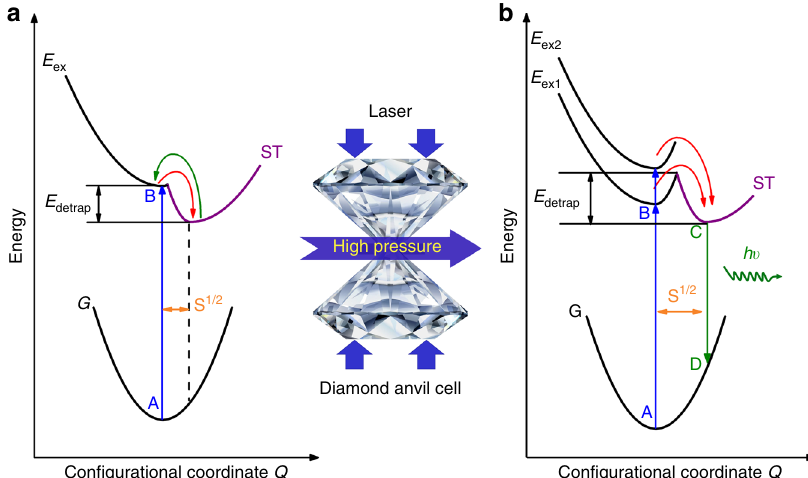
Fig. 4 Pressure-induced emission mechanism associated exciton self-trapping in NCs. Con fi guration coordinate model of emission for the Cs 4 PbBr 6 NCs at 1 atm ( a ) and 4 GPa ( b ). Herein, the absorption transition upon excitation from A to B is described. The STE recombination emission is depicted from C to D. The path between B and C refers to exciton self-trapping (red) and detrapping (green). ( E detrap ): activation energy for detrapping, ( E ex1 and E ex2 ): splitting of the bound exciton state, (ST): self-trapped state, (G): ground state, S 1/2 : Huang-Rhys